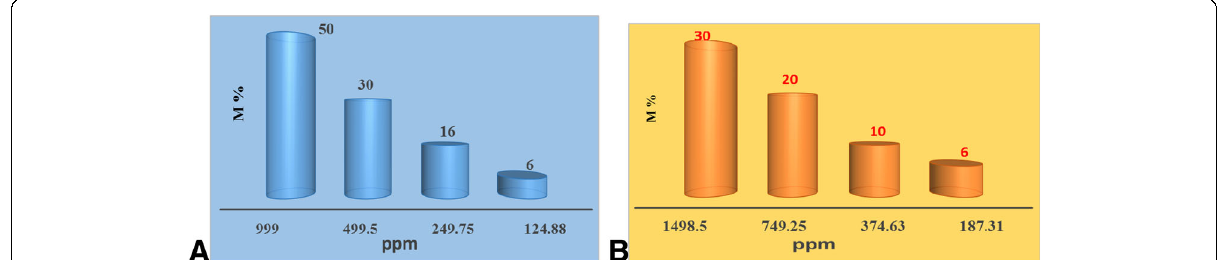
Fig. 4 The mortality percentages of second-instar larvae for AgNPS to a laboratory and b field strains of Spodoptera. littoralis